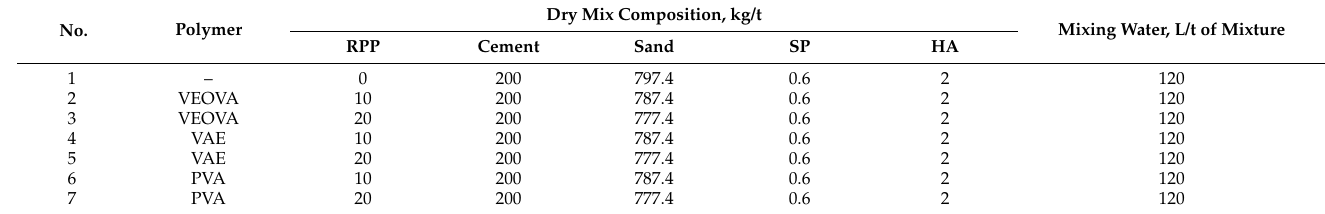
Table 3. Compositions of the studied mixtures suitable for 3D printer using RPP.